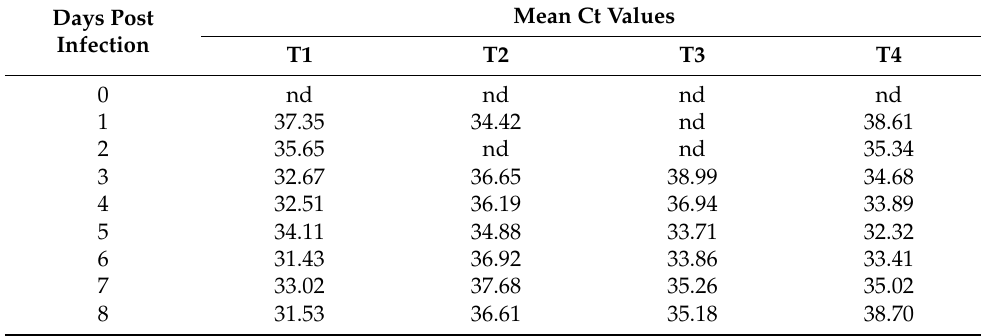
Table 1. Detection of viral load in nasal swabs from DCA2019 infected animals by RT ‐ PCR.